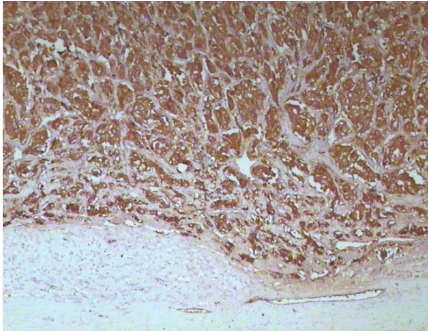
Figure 5: Diffuse cytoplasmic staining of tumor cells with an antibody specific for chromogranin A. Immunoperoxidase stain; mag ×